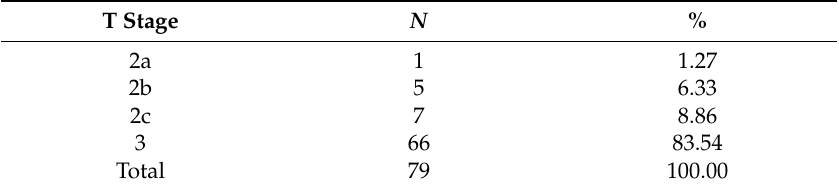
Table 4. Frequency of important clinical parameters for the study cohort. Clinical T Stage.